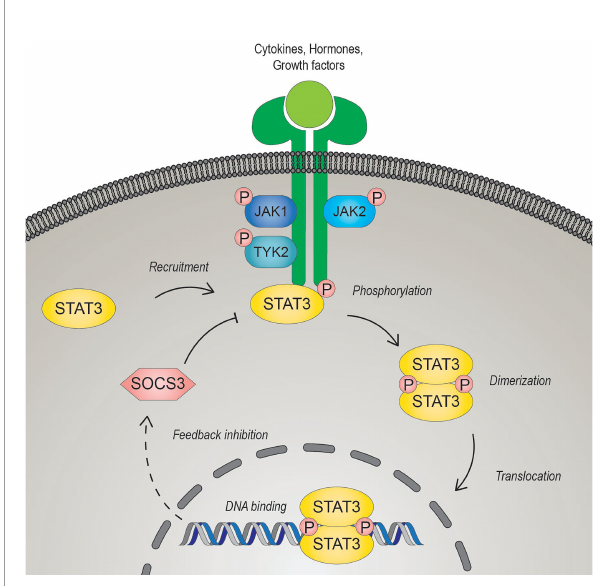
FIGURE 1 | The JAK-STAT3 signaling pathway. Signal transducer and activator of transcription 3 (STAT3) is activated upon binding of diverse cytokines, hormones, or growth factors to their cognate receptors. Ligand- bound receptors undergo conformational changes leading to the activation of the Janus kinases (JAK). Activated JAKs trans- and/or auto- phosphorylate each other and the cytoplasmic domain of the receptor, enabling STAT3 to bind via its SRC homology 2 (SH2) domain. JAK-mediated phosphorylation of a conserved C-terminal tyrosine residue of STAT3 induces dimerization of phosphorylated STAT3 and the subsequent translocation to the nucleus to regulate gene transcription. STAT3 induces transcription of suppressor of cytokine signaling 3 ( SOCS3 ), which can act as a negative regulator by interacting competitively with the